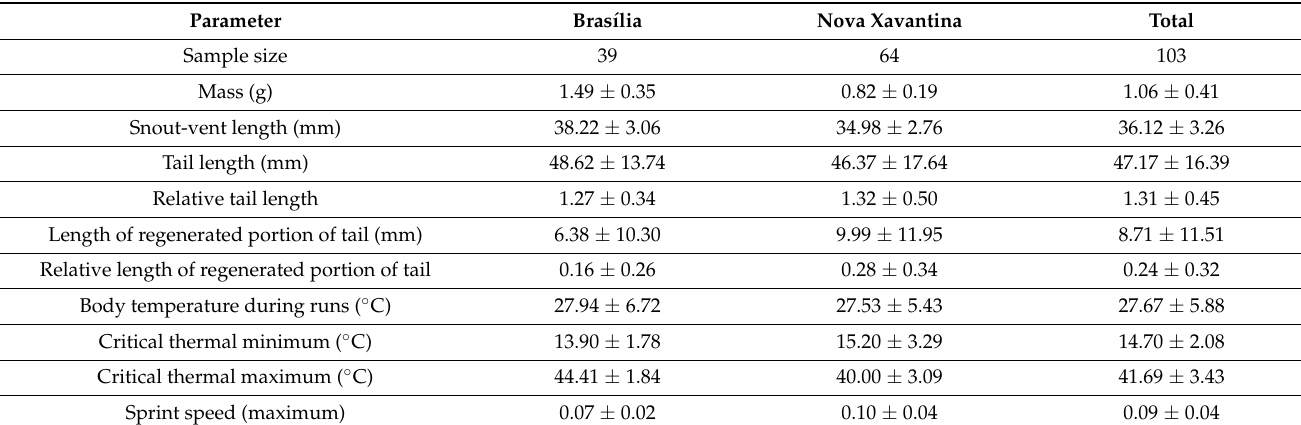
Table 1. Summary statistics of ecophysiological parameters of Micrablepharus atticolus from Bras í lia and Nova Xavantina, Brazil. Values represent the mean ± one standard deviation.